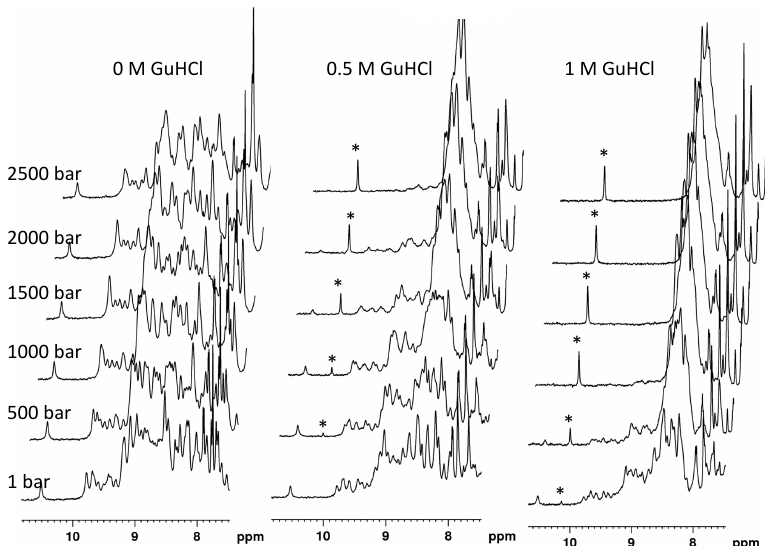
Figure 1. Determination of the experimental conditions (guanidine concentration) for the denaturation study of DEN4-ED3. Stacked plot of 1D 1 H spectra (amide region) recorded at variable pressure (from bottom to top) and variable concentration (0, 0.5, and 1 M, from left to right) of guanidine. Protein unfolding was monitored by following the rise of the indolic resonance of Trp103 in the unfolded state (indicated with an asterisk) and the concomitant decrease of the same resonance of Trp103 in the folded state (left: most resonance).